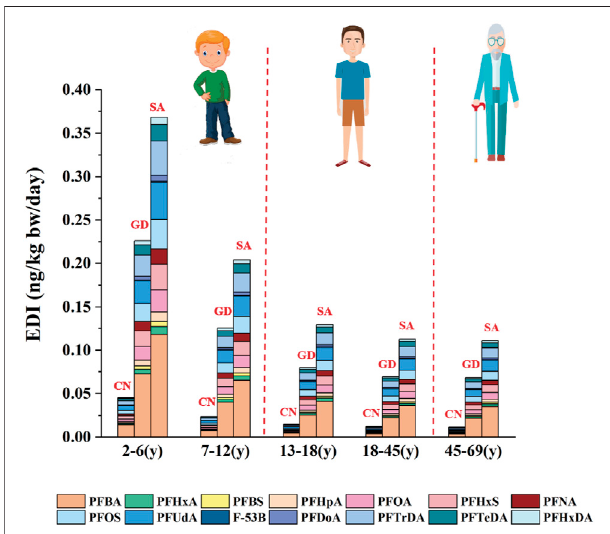
FIGURE 5 | Estimated daily intake of PFASs (ng/kg bw/day) via bullfrog for residents of different ages.